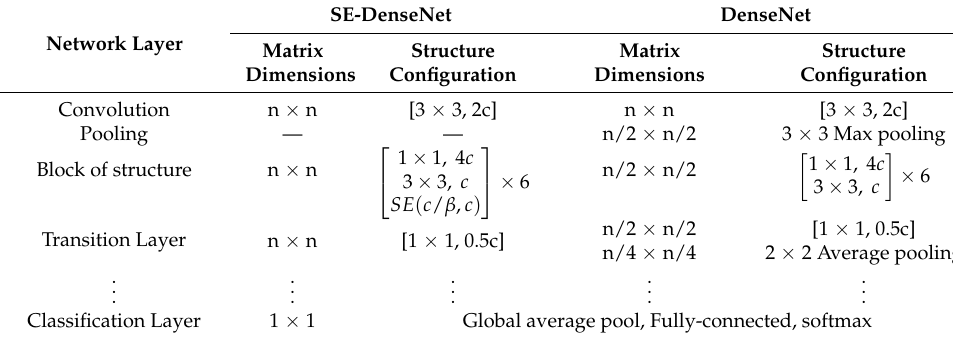
Table 1. SE-DenseNet network configuration information